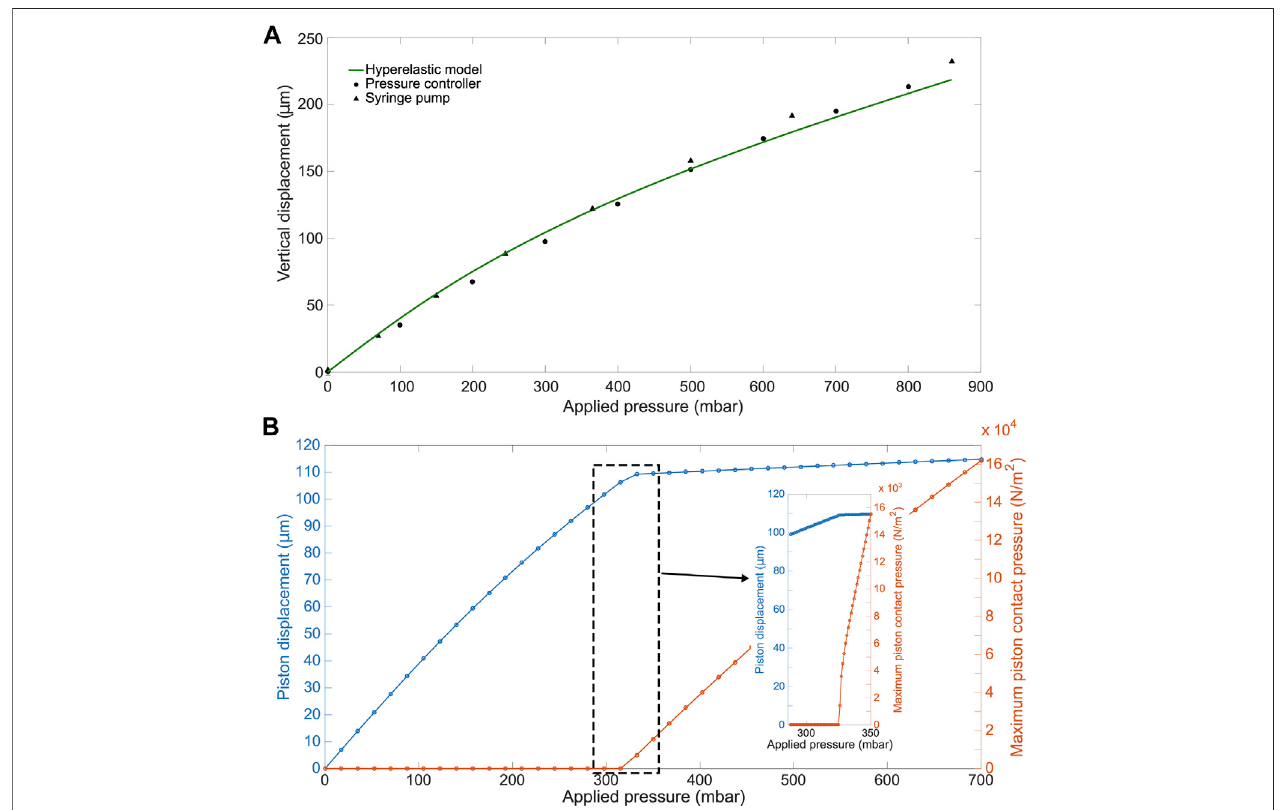
(cid:129) FIGURE 5 | COMSOL simulation results for the actuation of the micro-piston device. (A) Experimental ( , ▲ ) and computational (line) data comparison. (B) Plot of simulatedverticalseparationofthemicro-pistontopandthebottomglasssubstrate,andmaximumcontactpressureunderthemicro-pistonasafunctionofappliedgas pressure (boundary load). The applied externalpressurewasvaried from 0 to700 mbar in 40steps in themain plot. The inset shows more datapoints ofthe initialstage of the piston maximum contact pressure formation at mild pressures, part of the simulation run from 0 to 350 mbar in 320